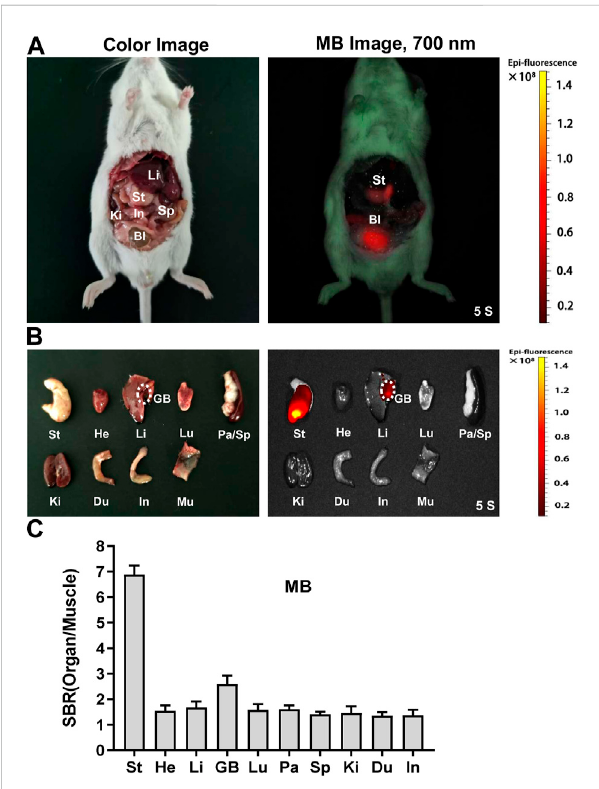
FIGURE 4 In vivo biodistribution and clearance of NIR fl uorophores MB. MB was injected intravenously into CD-1 mice, and the NIR fl uorescence signals were examined at 4 h post-injection under the NIR fl uorescence imaging system. (A) NIR imaging of the abdominal cavity of mice. (B) NIR imaging of resected tissues and organs at 4 h. (C) The signal-to-background ratio (SBR) was calculated by comparing the signals of major organs against the surrounding muscle. Abbreviations are GB, gall bladder; He, heart; In, intestine; Ki, kidney; Li, liver; Lu, lung; Sp, spleen; St, stomach. Each sample used three